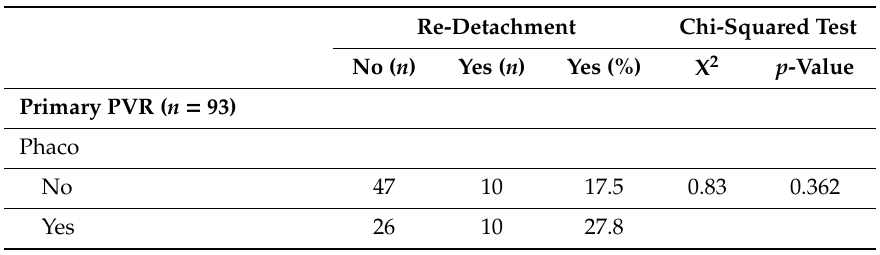
Table 3. Association between the occurrence or re-detachment and type of retinopexy for high-risk subgroups (with primary PVR or silicon oil